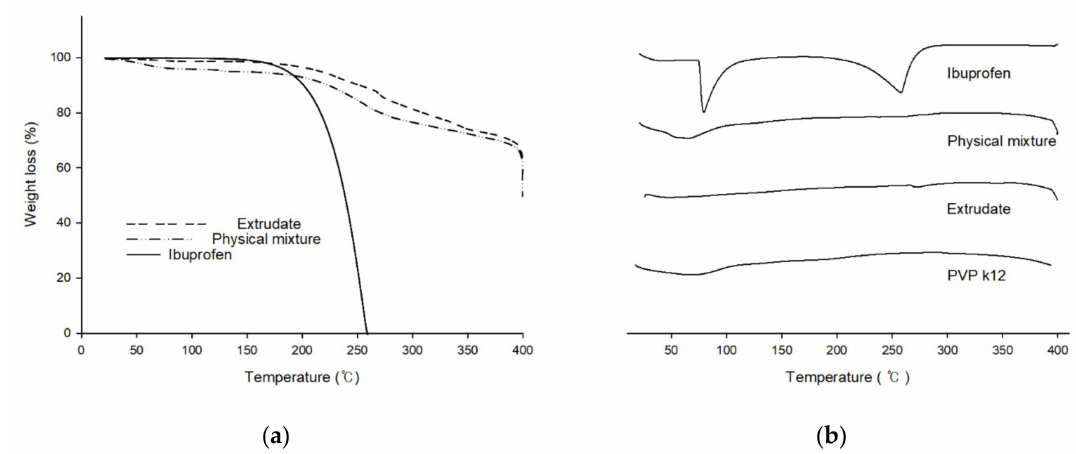
Figure 5. Thermal analysis result. ( a ) Thermogravimetry analysis (TGA) plots of extrudate, physical mixture and ibuprofen. ( b ) Di ff erential thermal analysis (DTA) plot of ibuprofen, physical mixture, extrudate, and PVP K12.